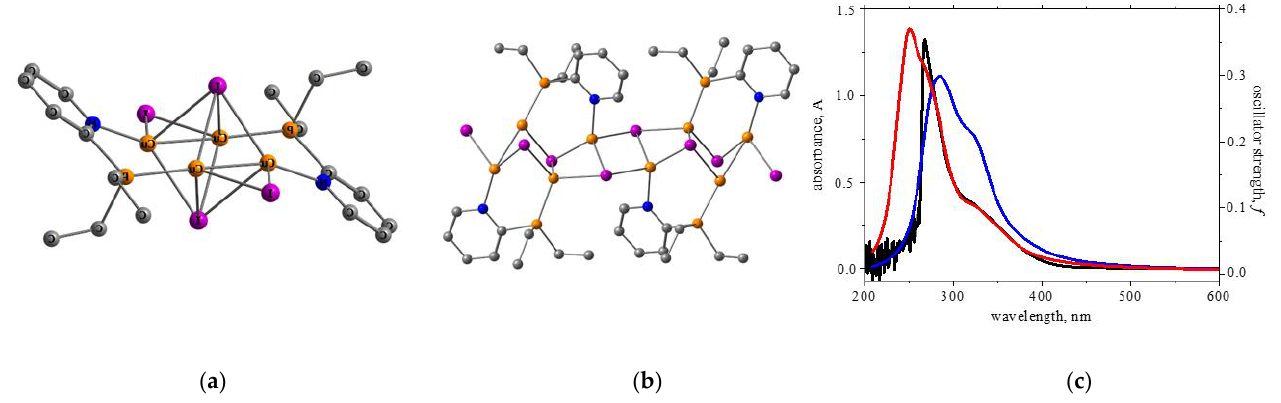
Figure 6. Quantum-chemically optimized monomeric ( a ) and dimeric ( b ) models of polymer 2 (orange—Cu atoms, pink—I atoms, blue—N atoms, grey—C atoms); ( c ) the simulated UV/Vis spectra for the monomeric (red line) and dimeric (blue line) models, compared to the experimental (black line) spectrum of polymer 2.